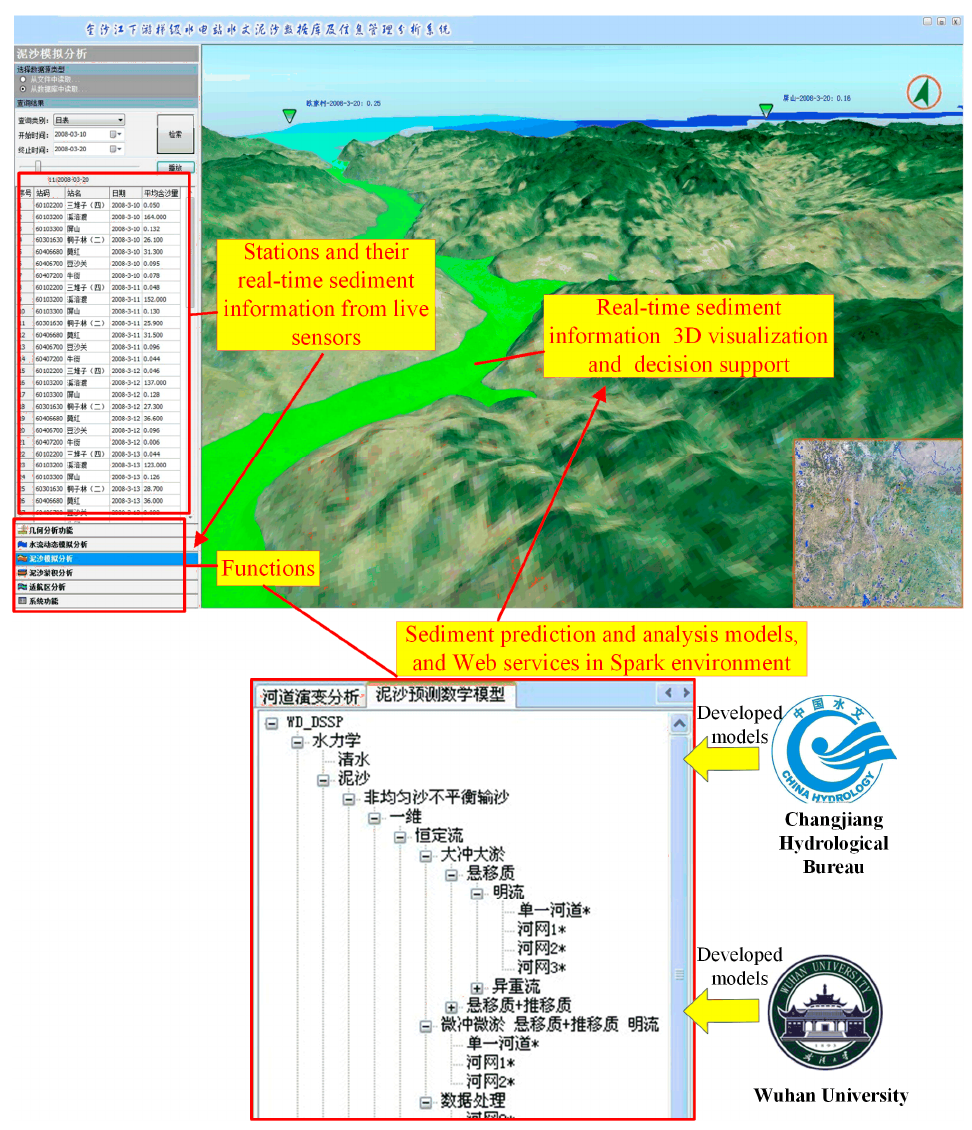
Figure 7. Visualization of the hydrology and sediment data and information with real-time data and information in an open way.